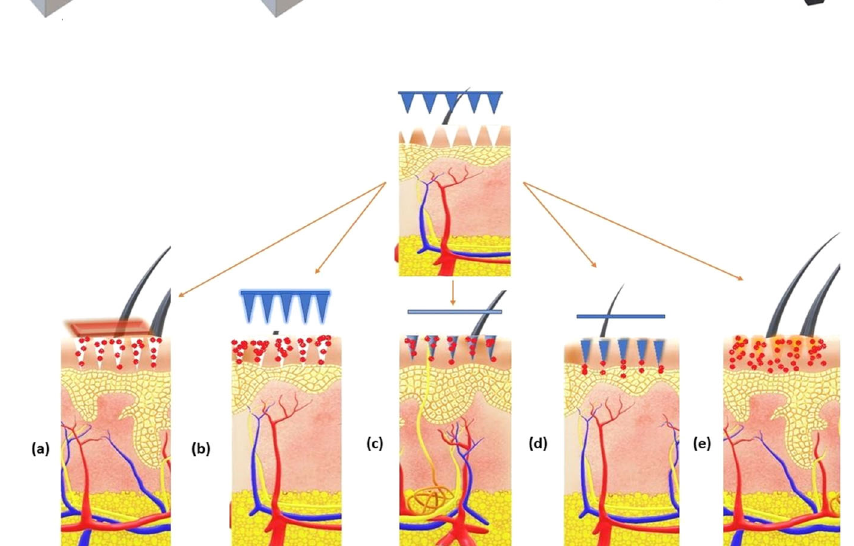
Fig. 4 Schematic representation of MNs A MN assembly ( a ) in- plane and ( b ) out-of-plane. B The design of out-of-plane MNs is de fi ned as ( a ) hollow and ( b ) solid. C Microarrays are ( a ) cylinder-shaped, ( b ) conical, ( c ) pyramidal, ( d ) and ( e ) pentagonal-based pointy and tapered tip, respectively